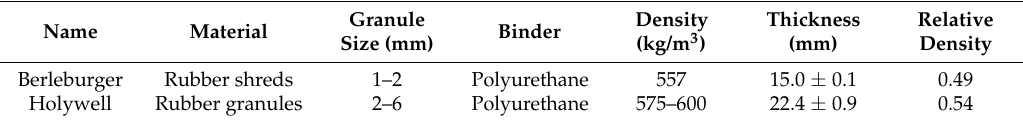
Table 1. Shockpad properties overview.